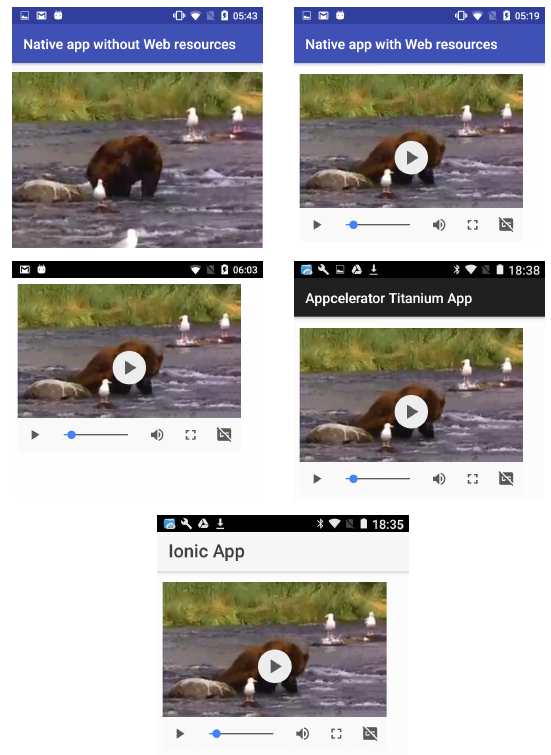
Fig. 3. Video player component implemented in the native application (without Web resources), native application (with Web resources), hybrid application, Appcelerator application and Ionic application,